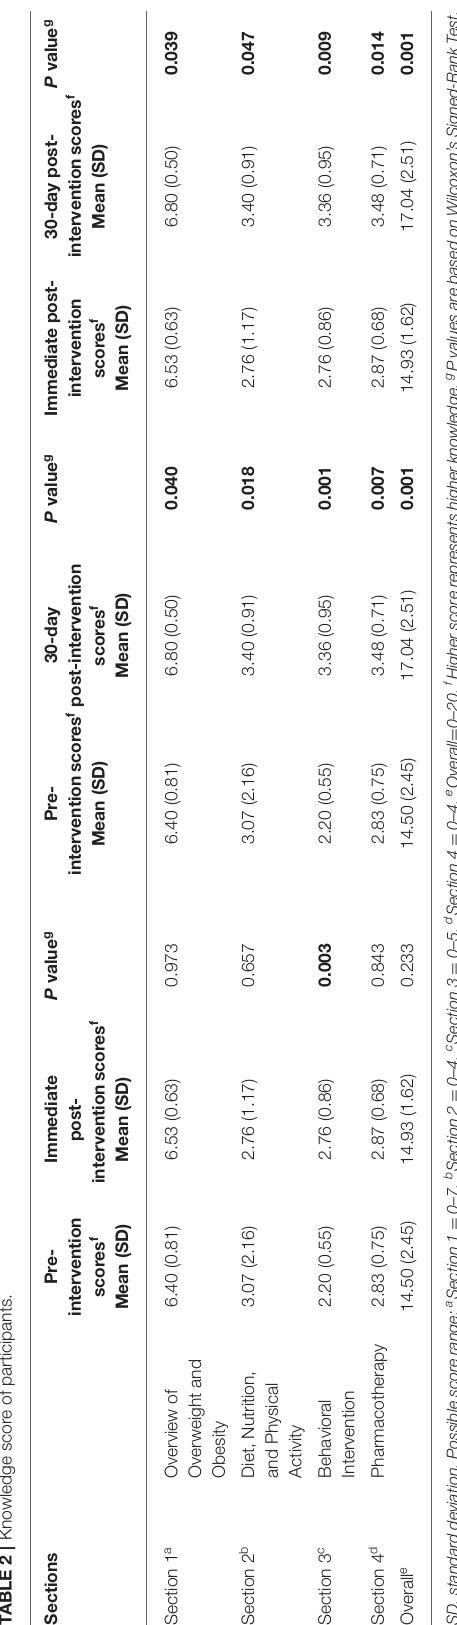
participants’ attitudes